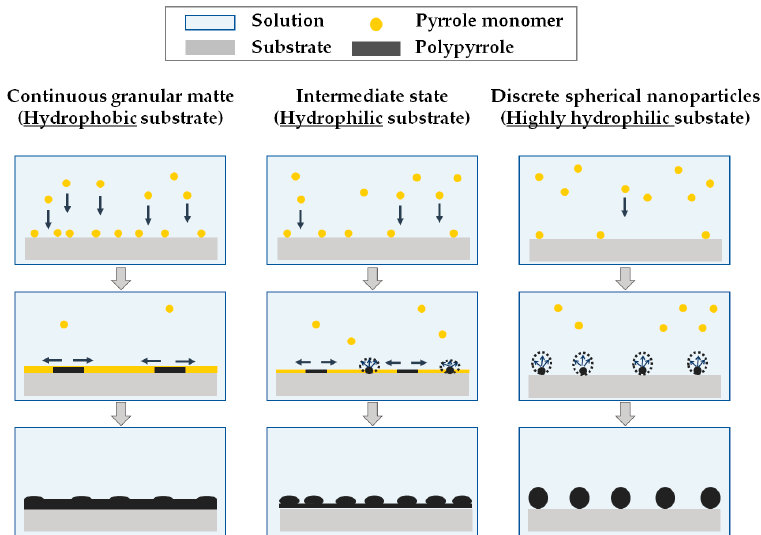
Figure 4. Diagram of nucleation and growth mechanism and morphology of polypyrrole according to the hydrophilicity of substrates.